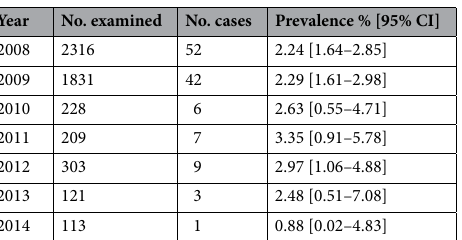
Table 3. Prevalence surveillance of echinococcosis in Yanghutaozi village of Xiaonangou Township by ultrasonography screening in 2008–2014. CI: confidence